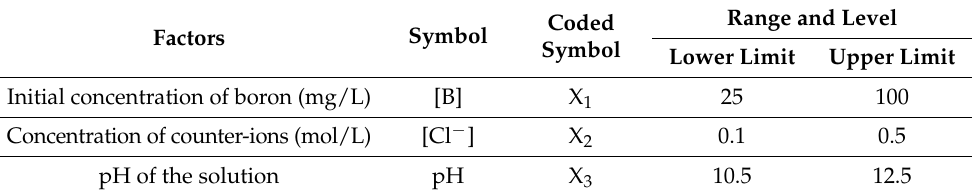
Range and Level Coded Symbol Lower Limit Upper Limit